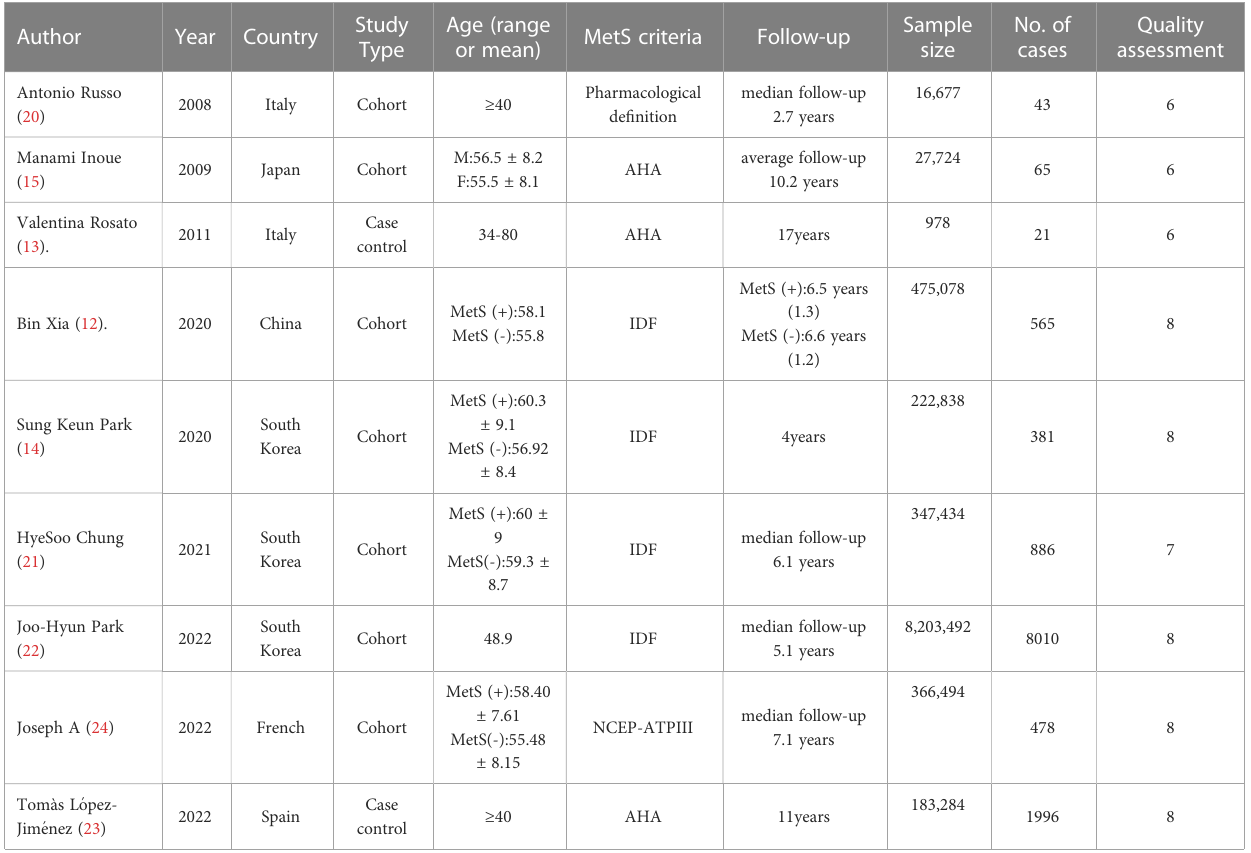
TABLE 1 Characteristics of the studies included in the quantitative and qualitative review.